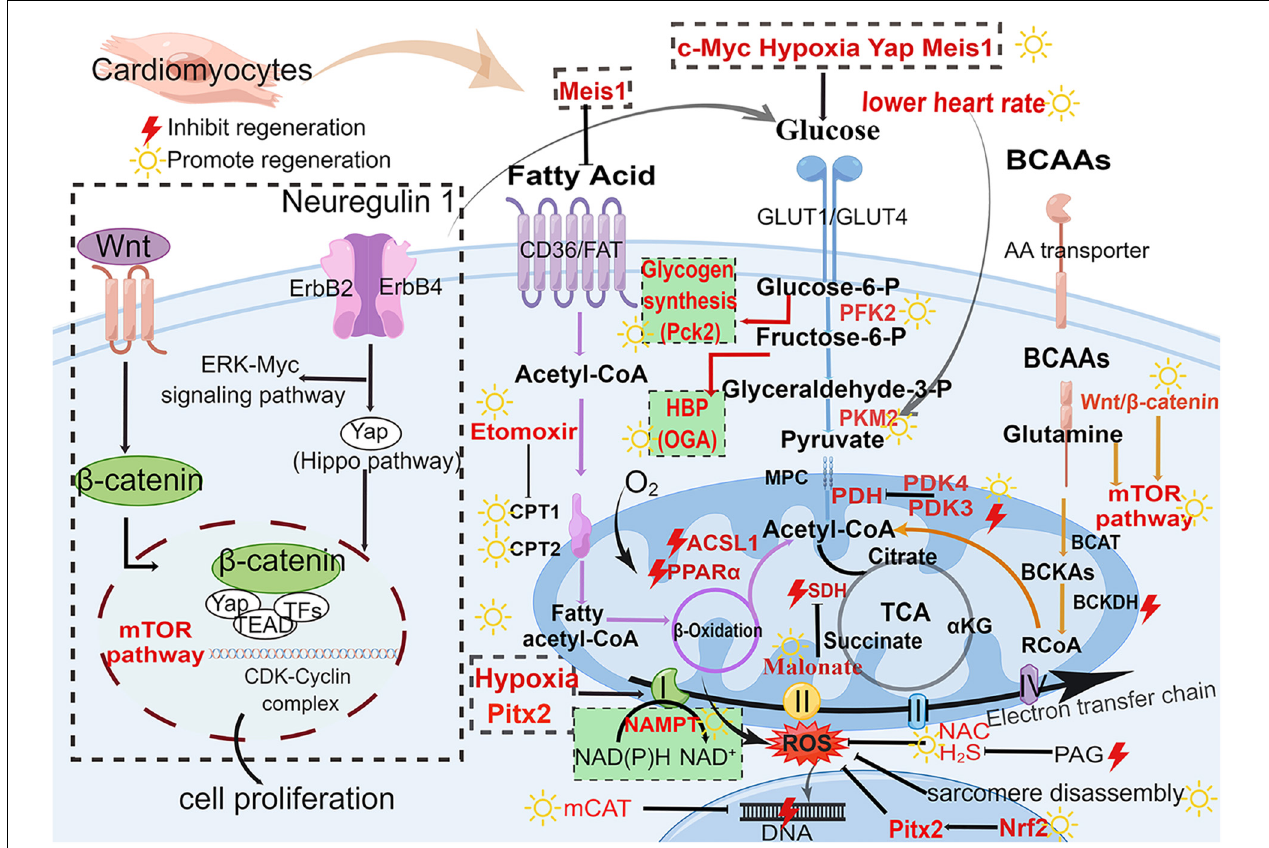
FIGURE 3 | Major metabolic pathways and signaling pathways in heart regeneration after cardiac injury. Glucose metabolism (blue), fatty acid metabolism (purple), BCAA metabolism (orange), and biosynthetic pathways (green background). The boxed section shows the factors affecting the metabolic pathways. Wnt/ β -catenin pathway and Nrg1-ErbB pathway affect the metabolism of heart regeneration. Acetyl-CoA is the final effector of these three metabolism pathways (fatty acid oxidation, glycolysis, and amino acid metabolism) and regulates the initiation of the TCA cycle. GLUT, glucose transporter type; Glucose-6-P, glucose-6-phosphate; Fructose-6-P, fructose-6-phosphate; Glyceraldehyde-3-P, glyceraldehyde-3-phosphate; PFK, phosphofructokinase; PKM2, M2-pyruvate kinase; PDK, pyruvate dehydrogenase kinase; PDH, pyruvate dehydrogenase; CD36, cluster of differentiation; FAT, fatty acid transport carrier; CPT, carnitine palmitoyltransferase; BCAAs, branched-chain amino acids; BCAT, branched-chain amino acid transferase; BCKA, branched-chain alpha-keto acids; BCKDH, branched-chain alpha-keto acid dehydrogenase; mTOR, mammalian target of rapamycin; TCA, tricarboxylic acid cycle; SDH, succinate dehydrogenase; α KG, α -ketoglutarate; ROS, reactive oxygen species; H 2 S, hydrogen sulfide; NAC, N -acetylcysteine; NAMPT, nicotinamide phosphoribosyltransferase; PAG, propargylglycine; mCAT, mitochondrial catalase; Pitx2, paired-liked homeodomain transcription factor 2; Nrf2, nuclear factor-erythroid-2-related factor 2; CDK, cyclin-dependent kinases; HBP, hexosamine biosynthesis pathway; Pck2, phosphoenolpyruvate carboxykinase 2; OGA, O -GlcNAcase. The yellow sun represents the promotion of heart regeneration, while the red lightning represents the inhibition of heart